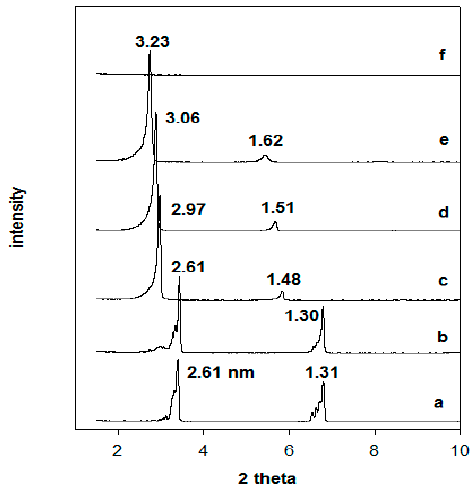
Figure 8. In situ powder XRD patterns of ( a ) C16TMABr solid salt preheated at different temperatures: ( b ) 100 °C, ( c ) 150 °C, ( d ) 200 °C, ( e ) 215 °C, and ( f ) 250 °C. ( b ) 100 ◦ C, ( c ) 150 ◦ C, ( d ) 200 ◦ C, ( e ) 215 ◦ C, and ( f ) 250 ◦